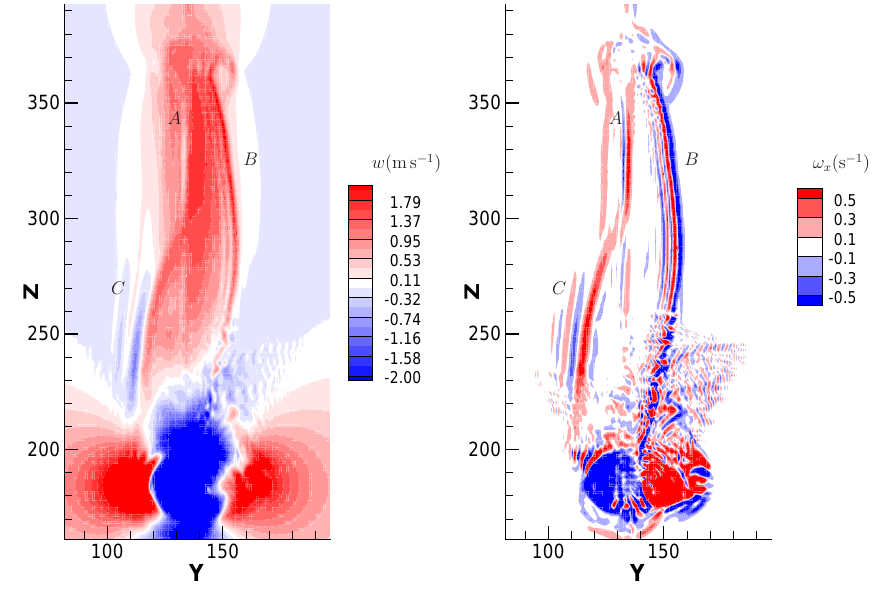
Fig. 4. Structure of the secondary wake in the cross-section yz at t = 120s ( V 1). Left: isocontours of the vertical velocity w . Right: isocontours of the axial vorticity ω x . Point A ( B ) in both panels indicates a counter-rotating vorticity sheet moving downward (upward). Gravity waves are then generated at point C .